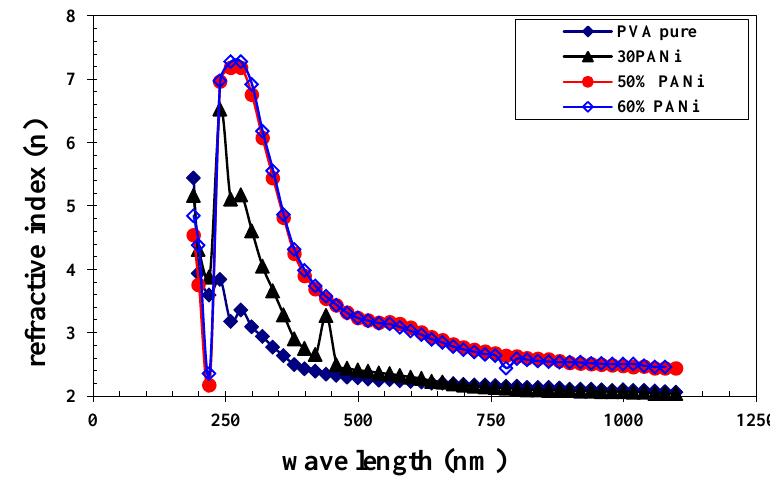
Fig. 5: Refractive index vs. wave length (nm) for (PVA +PNAI) blends polymer prepared with different PNAI percentage as a